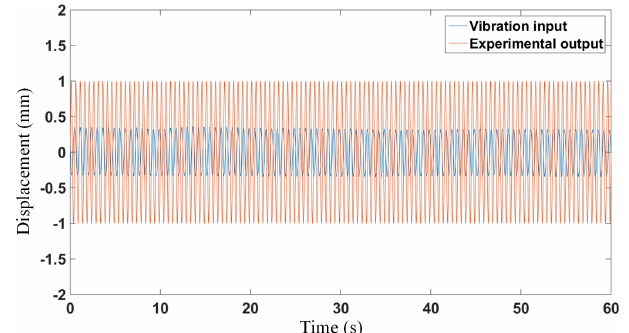
Figure 19. Experimental output at a vibration frequency of 2Hz and amplitude of